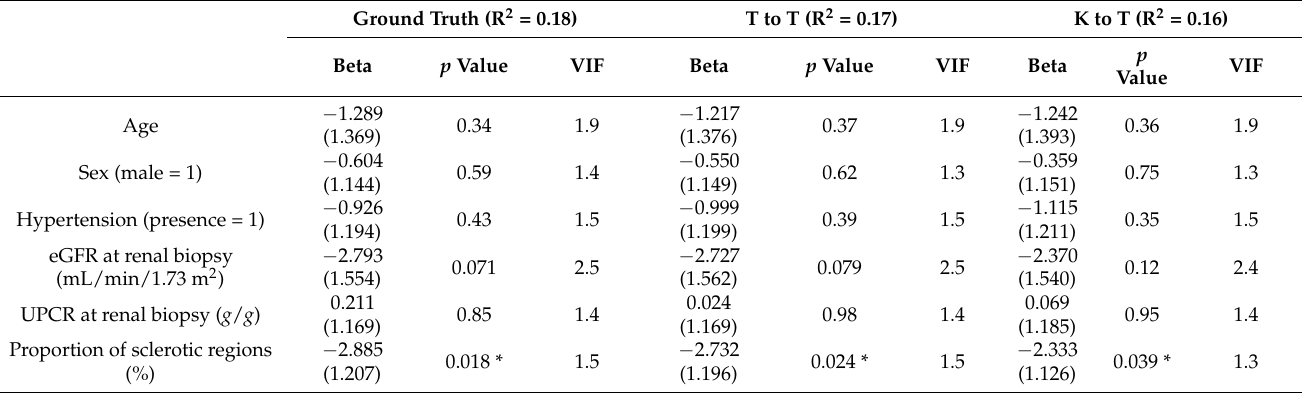
Table 5. Results of the multivariate regression